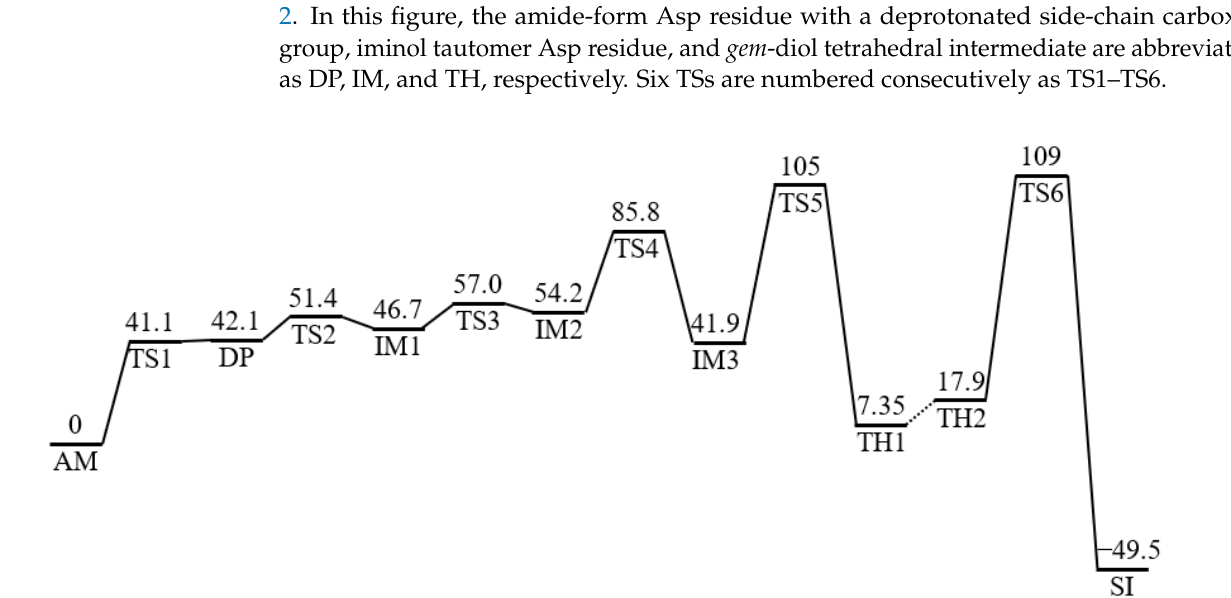
Figure 2. The energy profile of Suc residue formation from an Asp residue catalyzed by two water molecules. All relative energies were calculated at the MP2/6-311+G(d,p) level of theory and were corrected for zero-point energies (ZPEs) and thermodynamic corrections (to give the Gibbs energies at 1 atm and 298.15 K) calculated at the B3LYP/6-31+G(d,p) level of theory. All relative energies with respect to AM are provided in kJ mol −1 . DP, deprotonated side-chain carboxyl group; IM, iminol tautomer Asp residue; TH, gem -diol tetrahedral intermediate; TS, transition state.